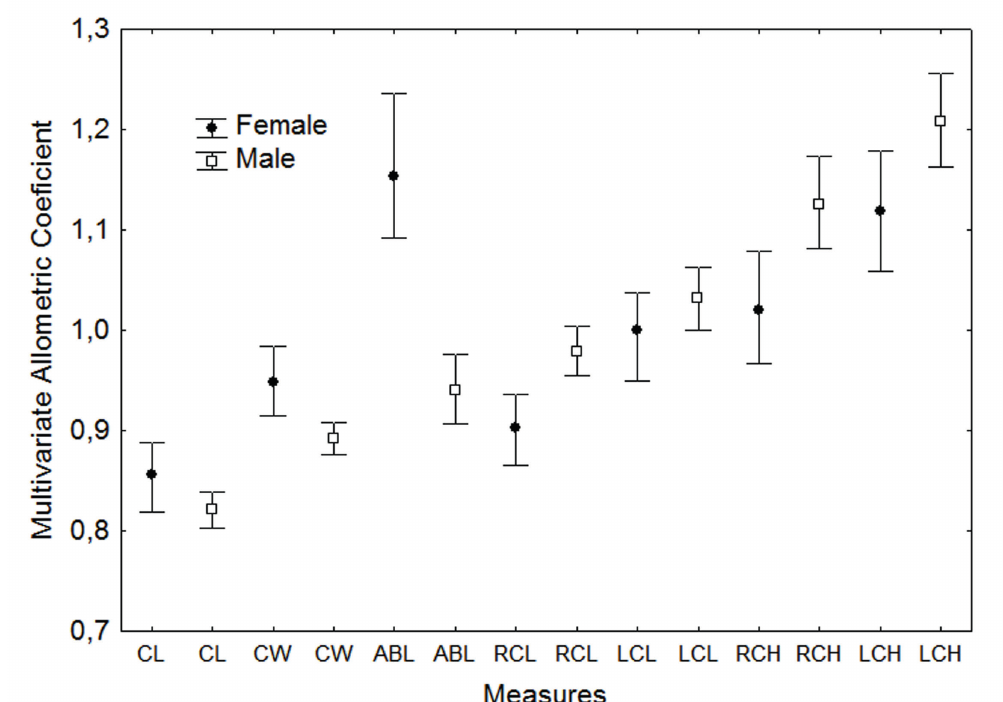
Figure 3. Multivariate allometric coefficient calculated for females and males of the Aegla marginata . Carapace Length (CL), Carapace Width (CW), Abdomen Length (ABL), Length of the Right (RCL) or Left (LCL), Cheliped, Height of the Right (RCH) or the Left (LCH)